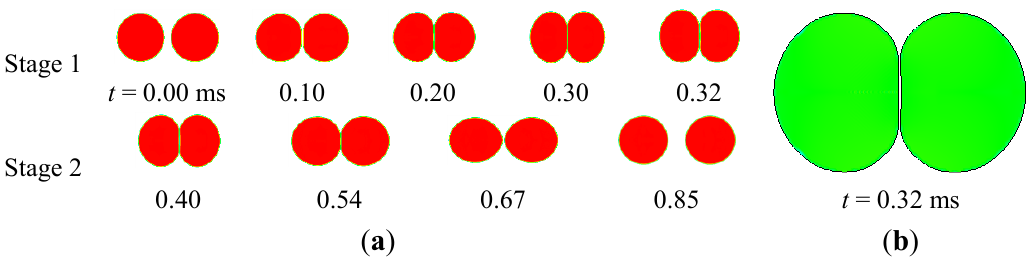
Figure 6. ( a ) Time evolution for bouncing collision and ( b ) Gaseous film between the two colliding